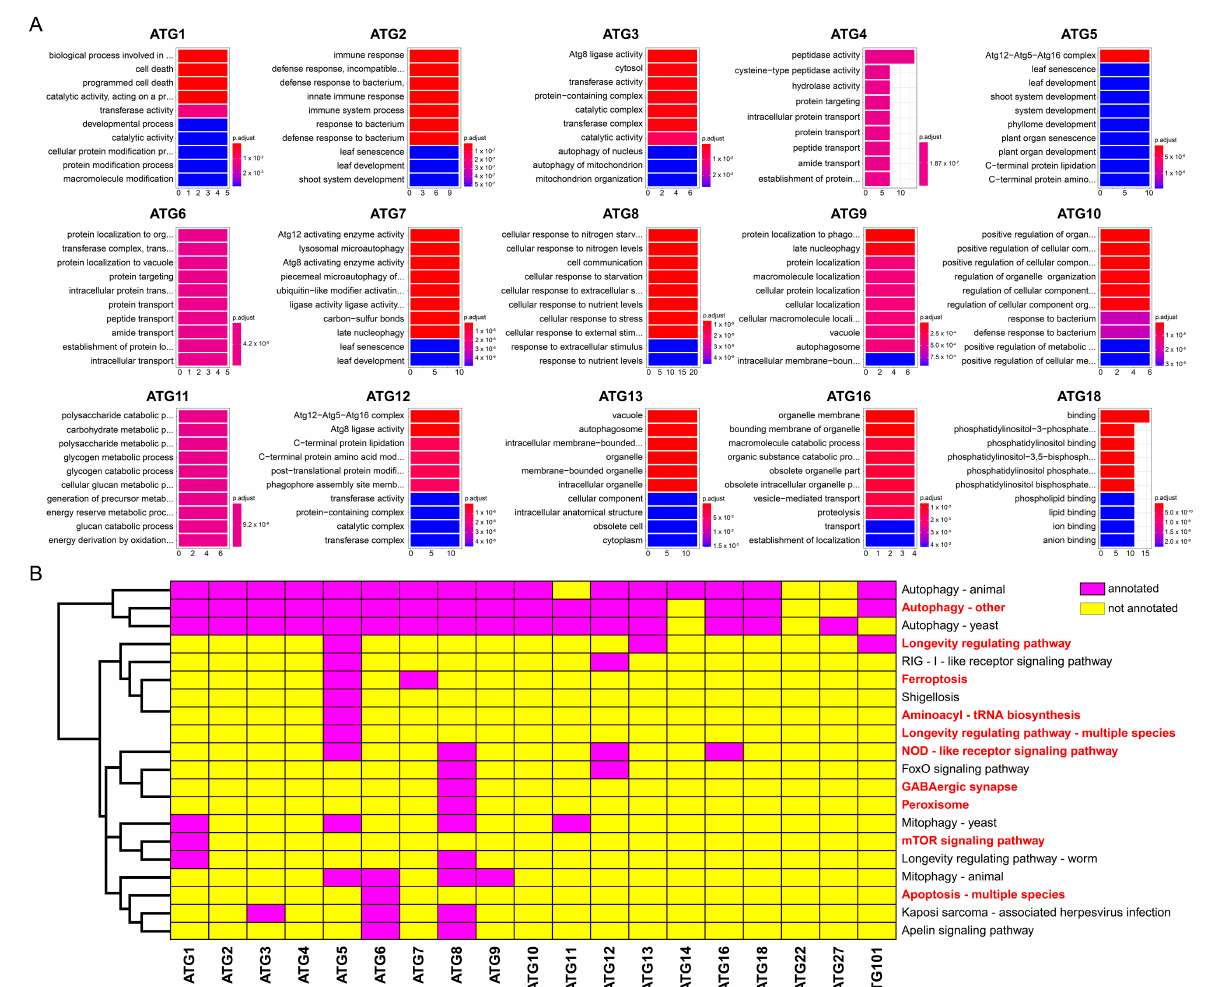
Figure 2. Annotation of identified ATGs. ( A ) GO enrichment of ATGs amongst different subfamilies. The top ten significantly enriched GO terms are displayed. The horizontal axis represents the number of ATGs which are annotated to the displayed GO terms; the vertical axis represents descriptive information of the enriched GO terms. Colors correspond to a value of p .adjust, which turns from blue to red as the p .adjust value changes from low to high. ( B ) KEGG enrichment of ATGs amongst different subfamilies. The horizontal axis represents autophagy subfamilies; the vertical axis represents descriptive information of annotated KEGG pathways. The fuchsia color denotes that the corresponding subfamily members were annotated in the KEGG pathway and the yellow color means that family members were not annotated. KEGG pathways highlighted by bold red font refer that these pathways can be found in